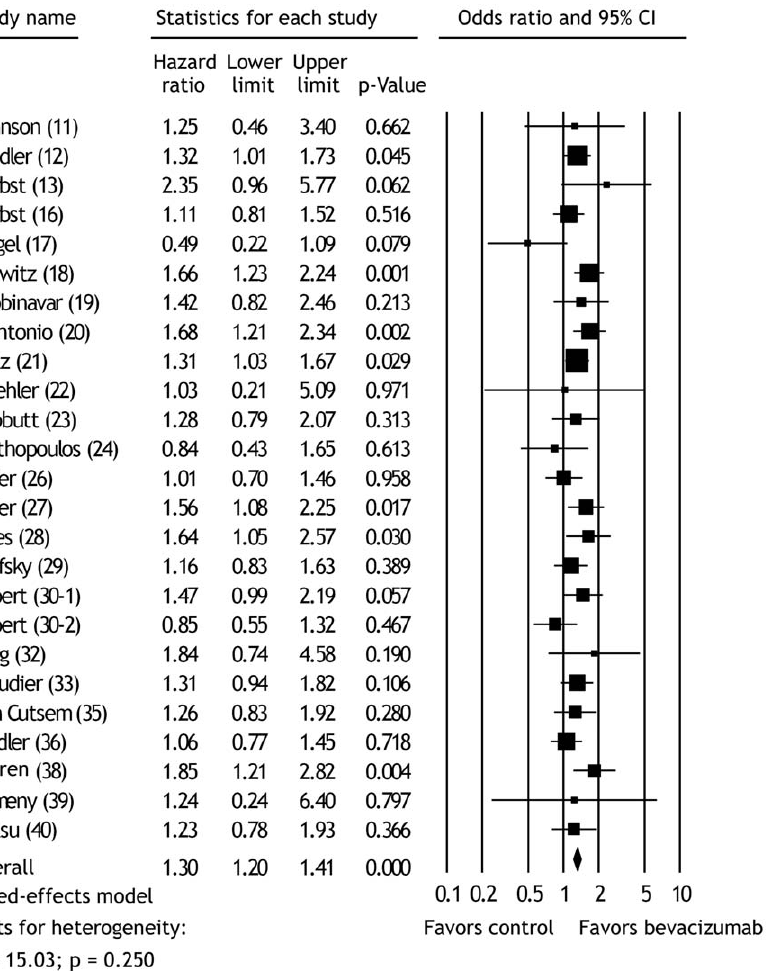
Figure 4. Meta-analysis of the odds ratios of one-year survival rate between bevacizumab and control therapy. Bars, 95% confidence intervals (CI) of odds ratio in patients receiving bevacizumab versus controls. The areas of the squares are proportional to the weights used for combining the data. The center of the lozenge gives the combined odds ratio. The odds ratio was considered statistically significant if the 95% CI for the overall odds ratio did not overlap one. Table S2 Subgroup analyses.